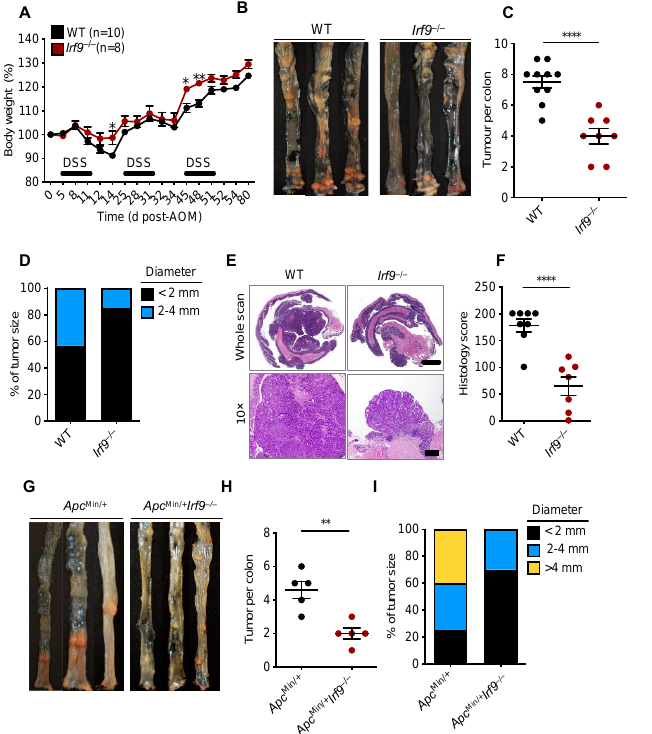
Figure 1. IRF9-deficient mice are resistant to the development of colorectal cancer . ( A ) Body weight change of wild type (WT) (n = 10) and Irf9 –/– (n = 8) littermate mice from one experiment, representative of three independent experiments. ( B ) Representative images of colon tumors in lit- termate WT and Irf9 –/– mice 80 days after injection of azoxymethane (AOM). ( C ) Number and ( D ) size of colon tumors in WT (n = 10) and Irf9 –/– (n = 8) mice. ( E ) Representative hematoxylin and eosin staining of colon tumors; scale bar, 2 mm for whole scan and 500 μm for 10×. ( F ) Histological scores 80 days after injection of AOM in WT (n = 8) and Irf9 –/– (n = 7) mice. ( G ) Representative images of colon tumors in 120-day-old littermate Apc Min/+ and Apc Min/+ Irf9 –/– mice. ( H ) Number of colon tumors in 120-day-old Apc Min/+ (n = 5) and Apc Min/+ Irf9 –/– mice (n = 5) mice. ( I ) Percentage of tumors of various sizes in 120-day-old littermate Apc Min/+ (n = 5) and Apc Min/+ Irf9 –/– (n = 5) mice. Each symbol represents 1 individual mouse (C, F, and H). * p < 0.05; ** p < 0.01; **** p < 0.0001. Two-tailed t-test (C, F, and H) and one-way ANOVA (A) were used. Data are represented as mean ± SEM in A, C, F, and H.